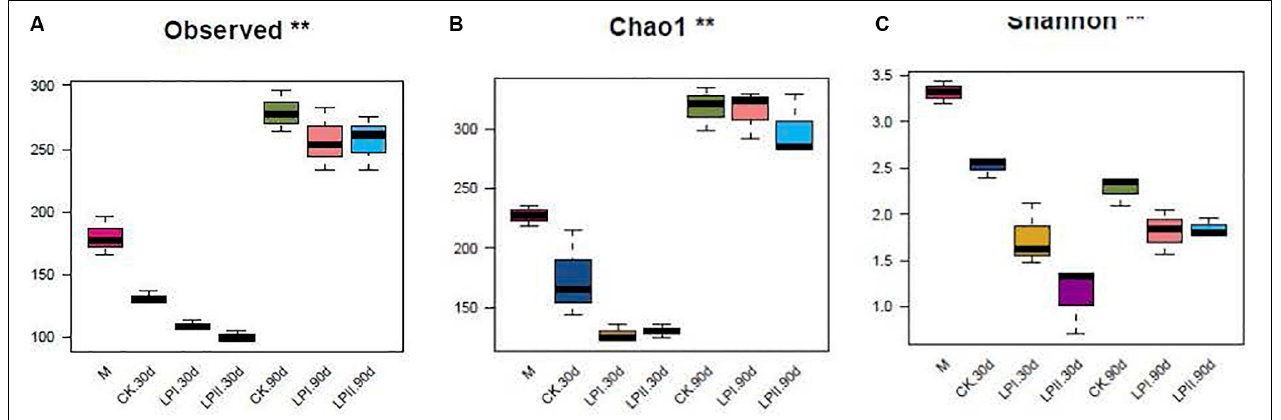
Means of three observations. Values with different letters in a row indicate significant differences among treatments (P < 0.05). DM, dry matter; LA, lactic acid; AA, acetic acid; LA/AA, lactic acid/acetic acid; PA, propionic acid; NH 3 -N, ammoniacal nitrogen; WSC, water soluble carbohydrate. % fresh weight for DM; % total nitrogen for